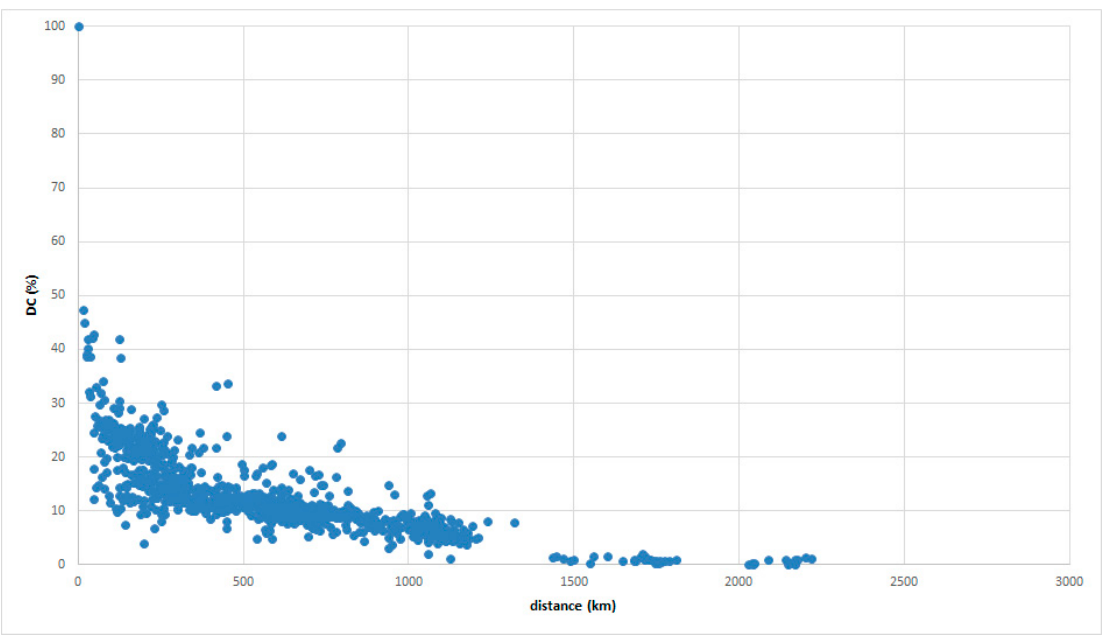
Figure 5. GAJ data with reference place in Tohoku.